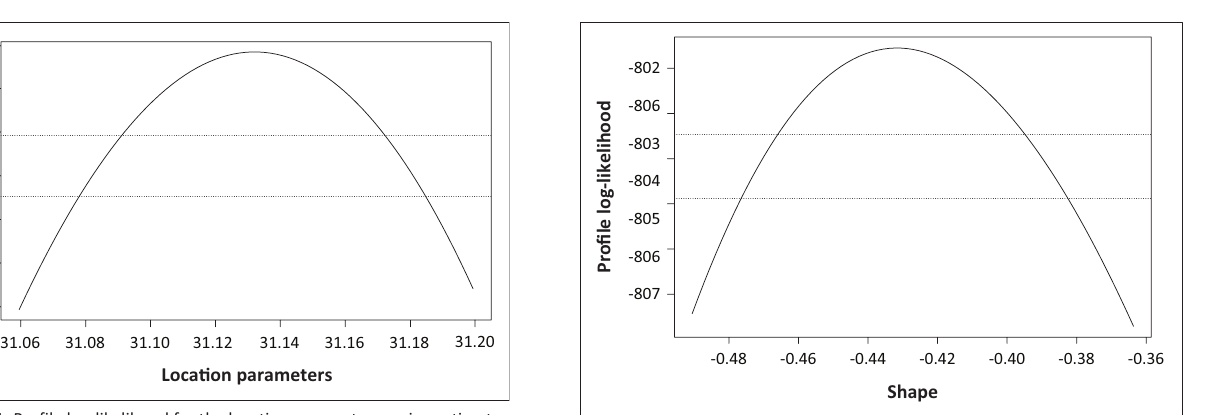
FIGURE 4-A1: Profile log-likelihood for the location parameter μ using estimates of the model with r = 4.